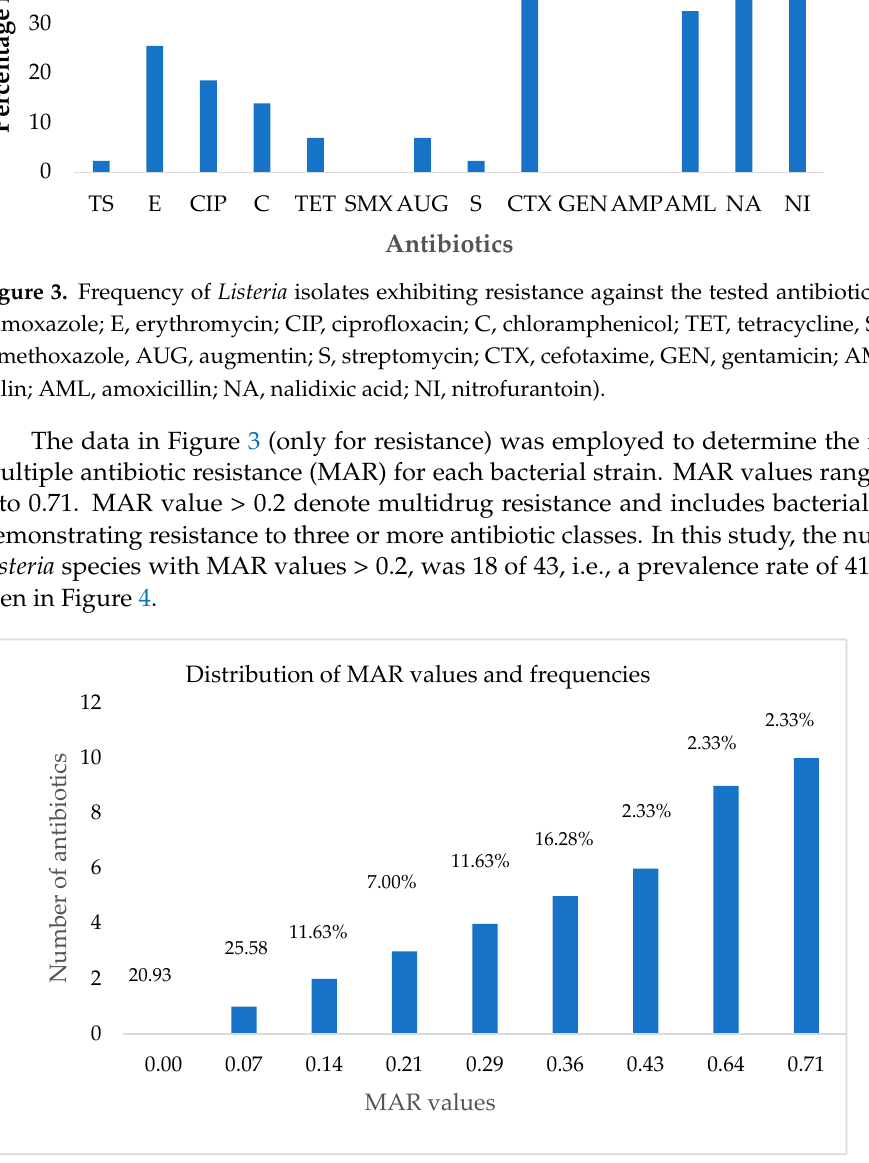
Figure 4. Distribution of MAR values and frequencies of Listeria isolates in the study . Multiple resistance to antibiotics (MDR) in the isolates was further investigated based on the categories of the antibiotics evaluated in the investigation. The different MAR phenotypes identified in this study are presented in Table 2. A total of 18 MAR phenotypes was identified. It was observed that only one isolate exhibited resistance to ten